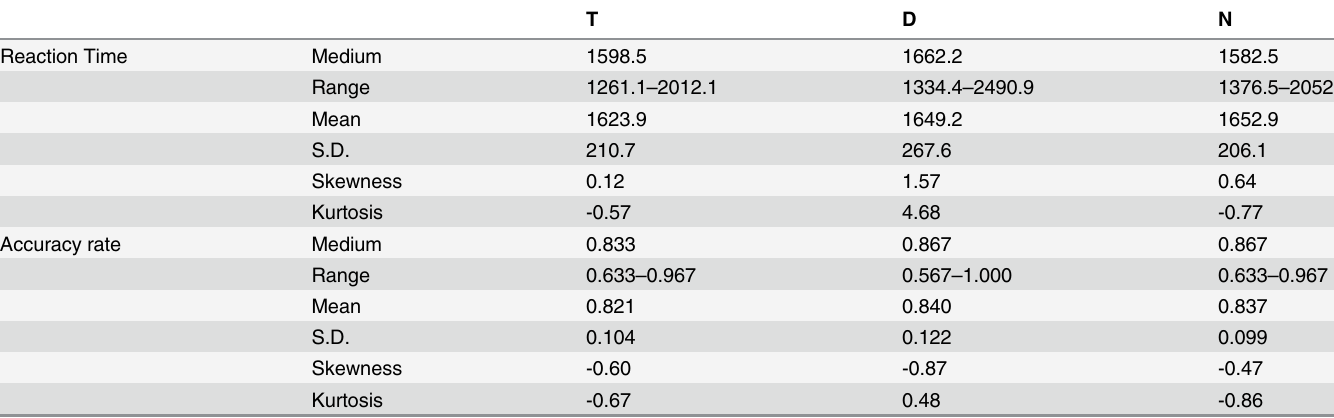
Table 1. Descriptive statistical results of behavioral